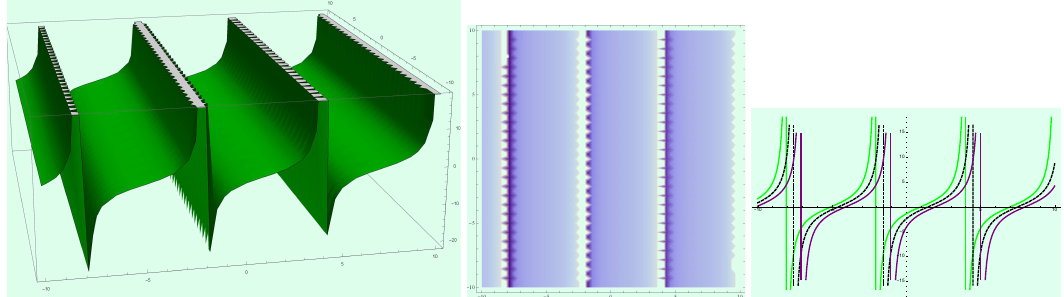
Figure 14. Profile of traveling wave solution (28) when t = 0 and x = − 4.